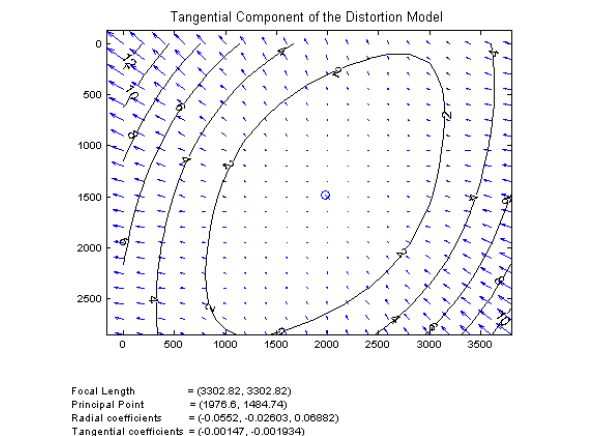
Figure 4: On the top, the residual deformation due to tangential distortions without any correction by additional parameters. In the middle, the same deformation after correction by Bingo parameters. At the bottom, the tangential distortion of PiX4D calibration but the images residuals grid was not available to compare with Bingo grid.